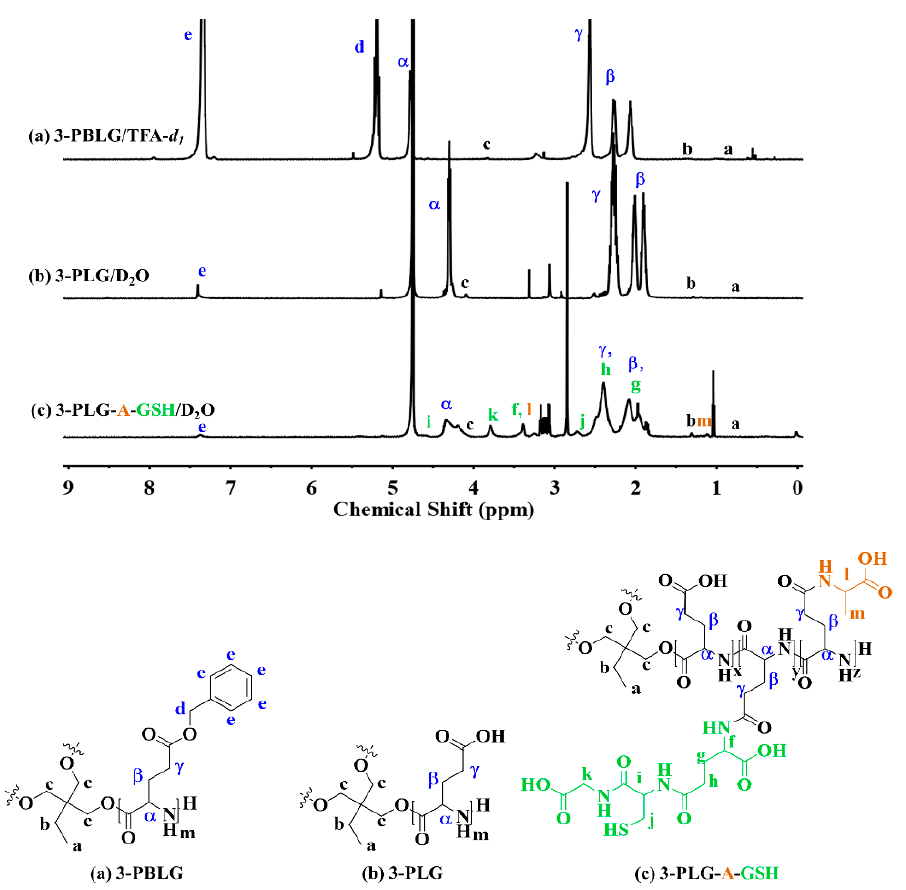
Figure 2. 1 H NMR spectra and structure of ( a ) 3-armed poly( γ -benzyl- L -glutamic acid (3-PBLG) in trifluoroacetic acid (TFA- d 1 ), ( b ) 3-armed poly( L -glutamic acid) (3-PLG) in deuterium oxide (D 2 O), and ( c ) L -alanine and glutathione-targeted 3-armed poly( L -glutamic acid) (3-PLG-A-GSH) in D 2 O.